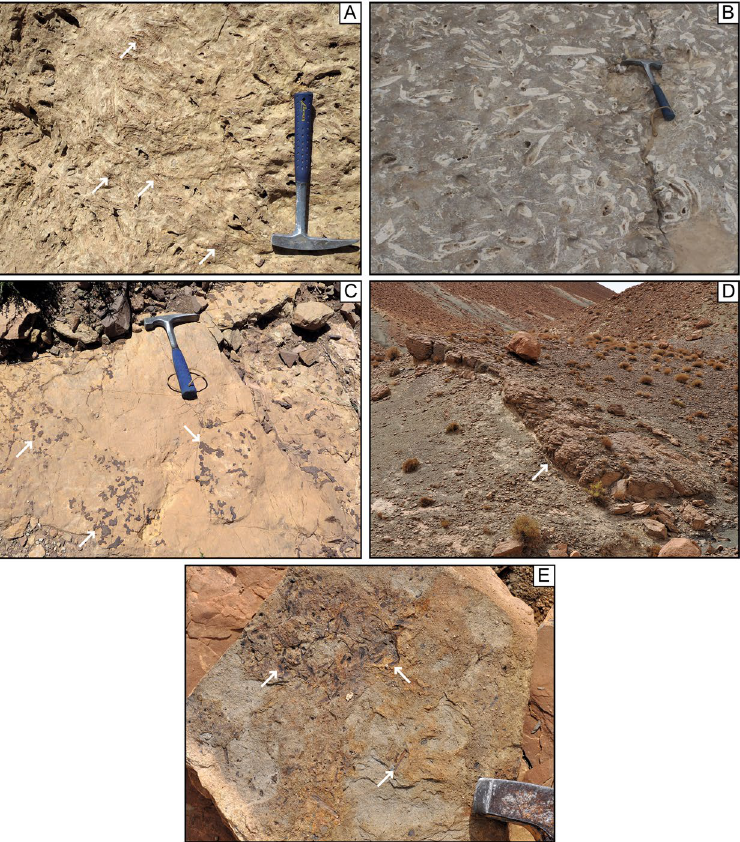
Figure 4. ( A ) Dissolved lithiotid shells filled by vadose silts (white arrows) and embedded within a dolomitized matrix, below SB1 in proximal area, 350 m northwest of the infilling unit (Jebel Akenzoud, Dades Valley). ( B ) See non-dissolved lithiotid shells for comparison. ( C ) Dolomitic bed associated with SB1 in Taria n’Dades (most proximal section visited during this study). Note the iron oxides veneer (white arrows) on top of the dolomitic bed corresponding to TS1. ( D ) 40-cm-thick channelized packstone bed (max. 1 m thick; white arrow) composed of shallow-water components interbedded within deep-neritic marls (Amellago section). This feature is interpreted as a local shelf margin wedge associated with SB1. ( E ) Numerous plant debris (white arrows) are present within this